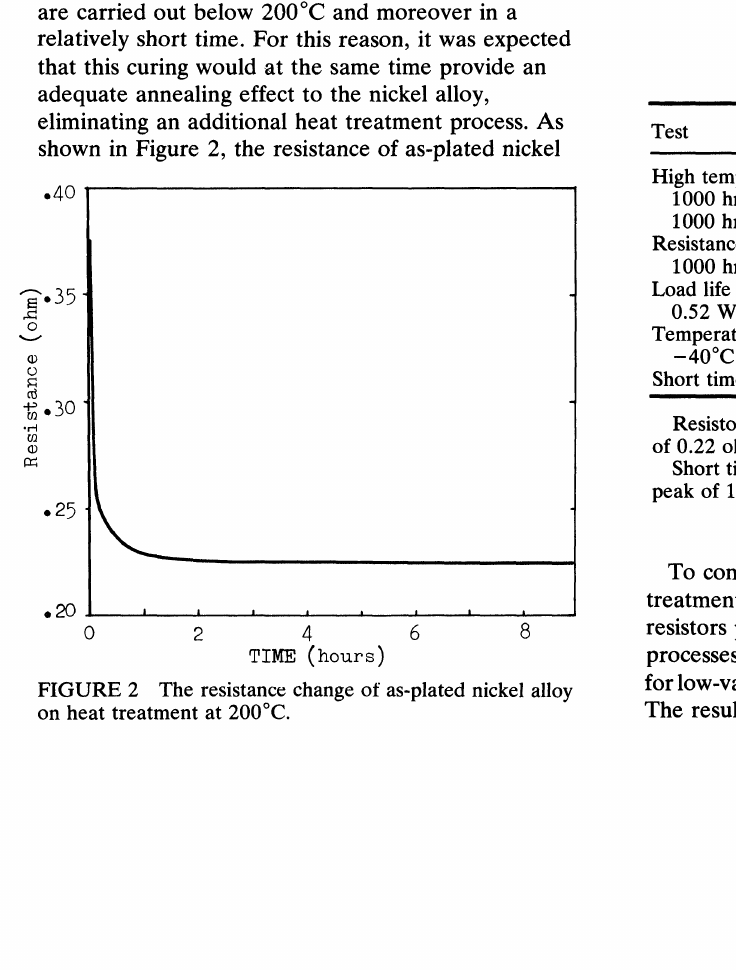
TABLE II Life test results of Ni-P alloy